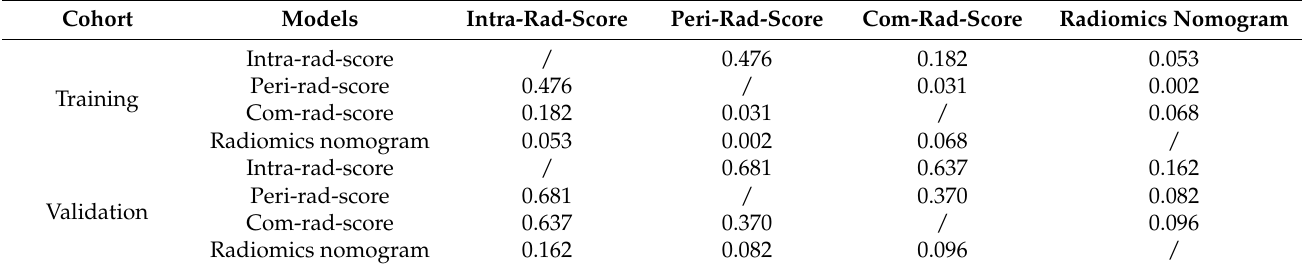
Table 4. The statistical comparison of AUC values using the DeLong test among four models.